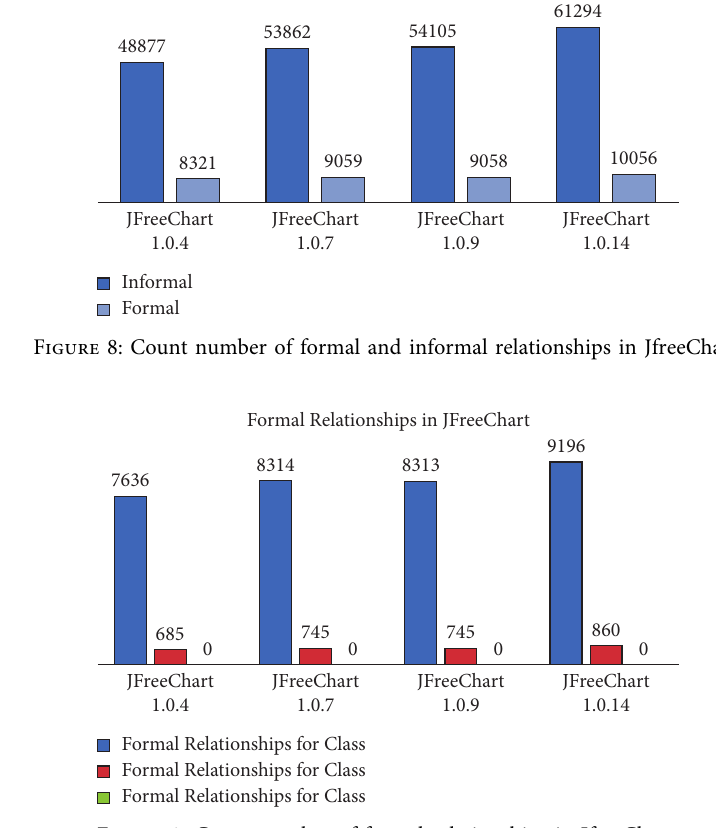
Figure 9: Count number of formal relationships in